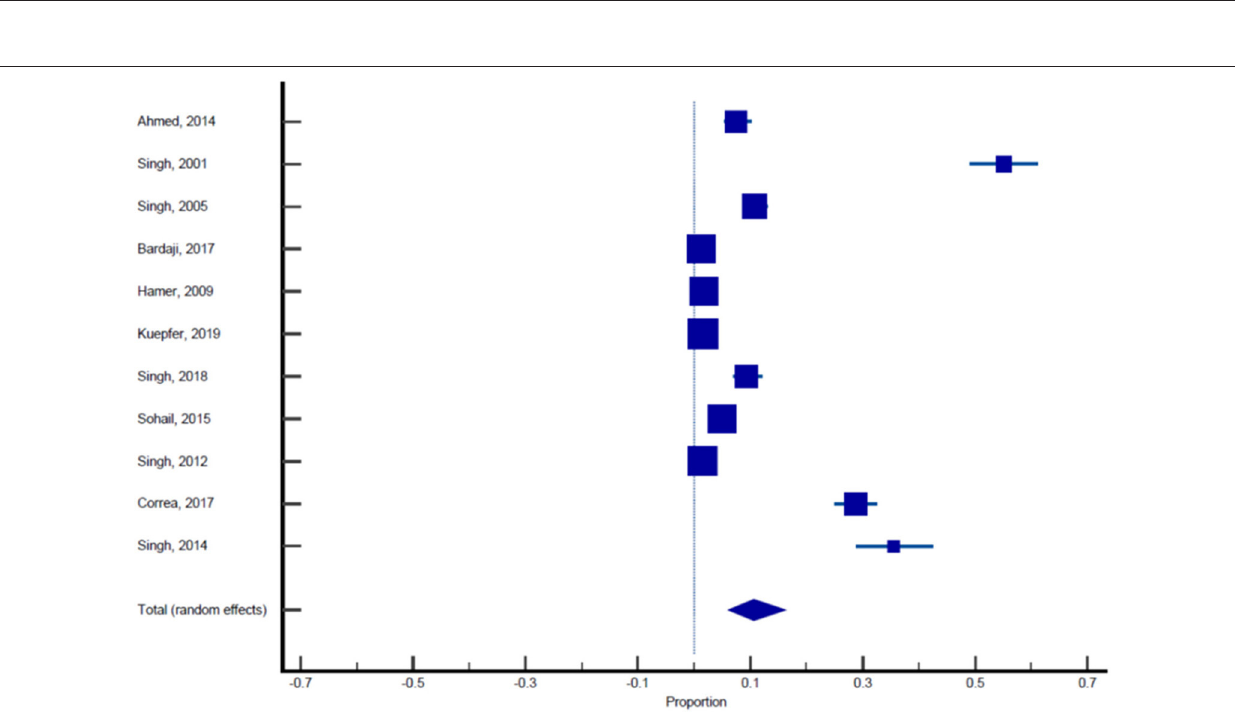
Frontiers in Global Women’s Health |